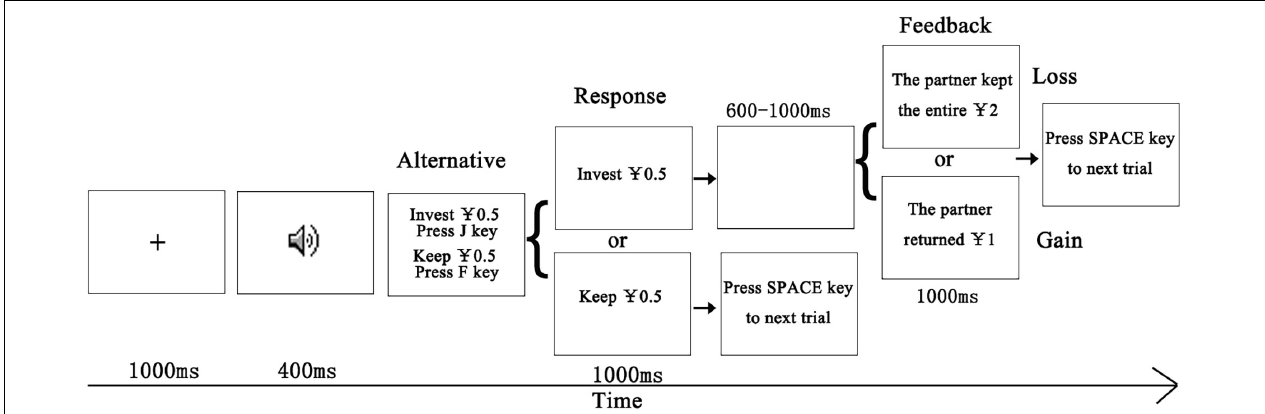
FIGURE 1 | The trial procedure of the trust game task. A central fixation cross was presented for 1,000 ms, followed by a voice of the partner presented for 400 ms. The participants would decide whether to invest (cid:85) 0.5 or keep it. The final decision would be presented for 1,000 ms. If the participant agreed to invest, the partner may either give (cid:85) 1 back to the participant or keep the entire (cid:85) 2. If the participant kept (cid:85) 0.5, they would retain the current amount of money.